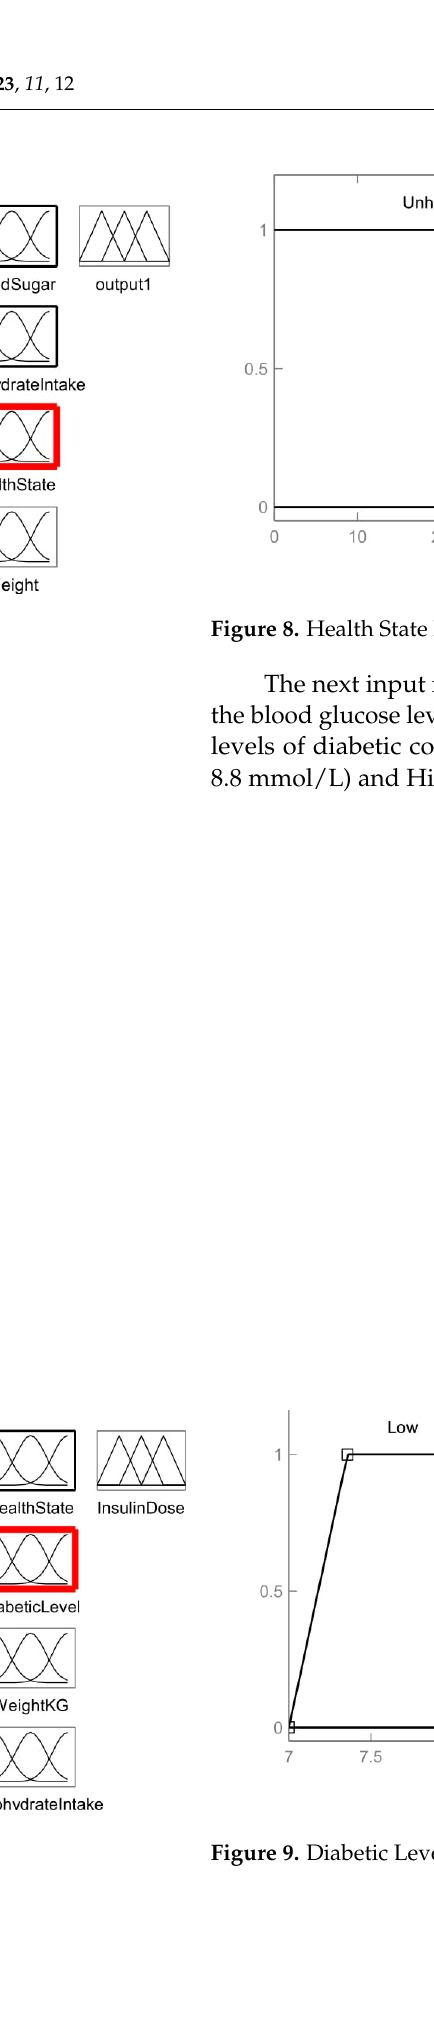
Figure 9. Diabetic Level Membership function.